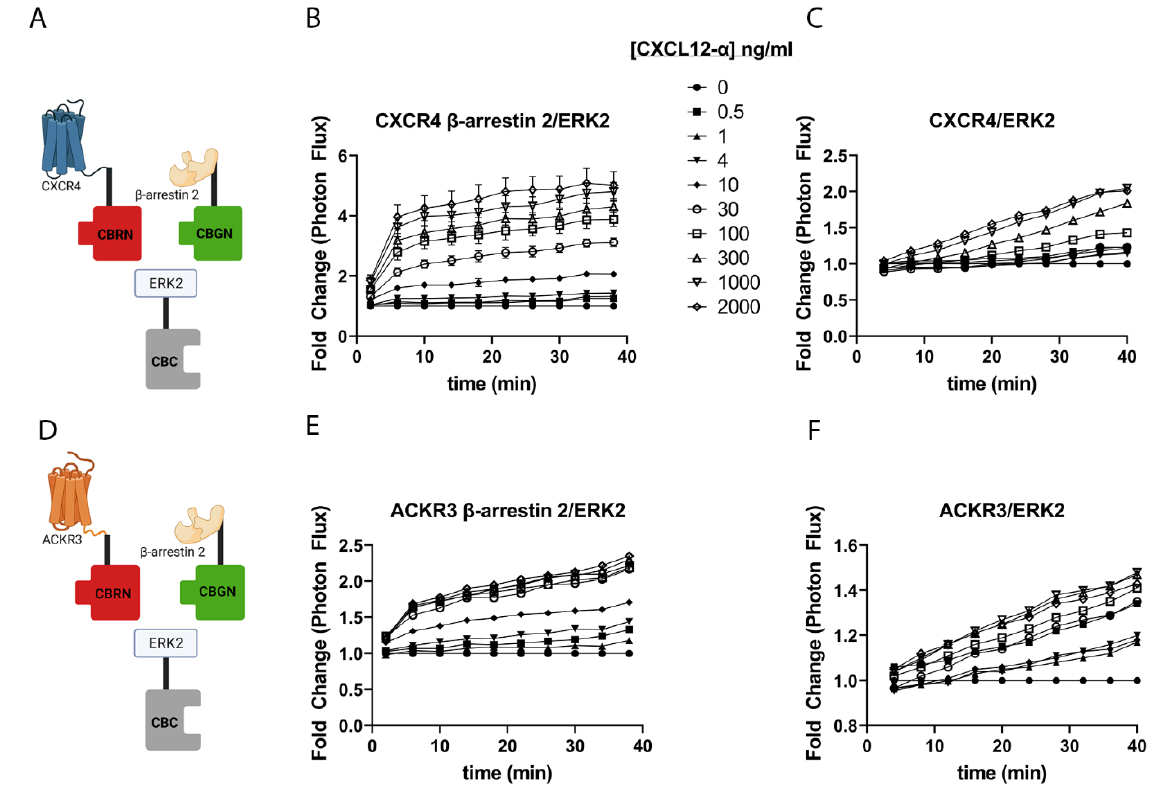
Figure 2. CXCL12 signaling through CXCR4 and ACKR3 promotes recruitment of ERK2 to β -arrestin 2 and receptors. ( A , D ) Schematic of dual-color click beetle luciferase complementation for association between CXCR4-CBRN ( A ) or ACKR3-CBRN ( D ) and β -arrestin 2-CBGN with ERK2-CBC. We used MDA-MB-231 cells stably expressing CXCR4-CBRN ( B , C ) or ACKR3-CBRN ( E , F ) with β -arrestin 2-CBGN and ERK2-CBC. We treated cells with increasing concentrations of CXCL12- α and imaged bioluminescence for 40 min, alternating images every 2 min in either green or red channels. The green complementation signal quantified the association of β -arrestin 2 with ERK2 ( B , E ), while the red channel measured interaction between the receptor and ERK2 ( C , F ). Graphs show mean values ± SEM for fold change in bioluminescence relative to cells treated with vehicle only. Error bars may be smaller than the presented symbol at each timepoint. Illustrations created with BioRender.com (accessed on 28 April